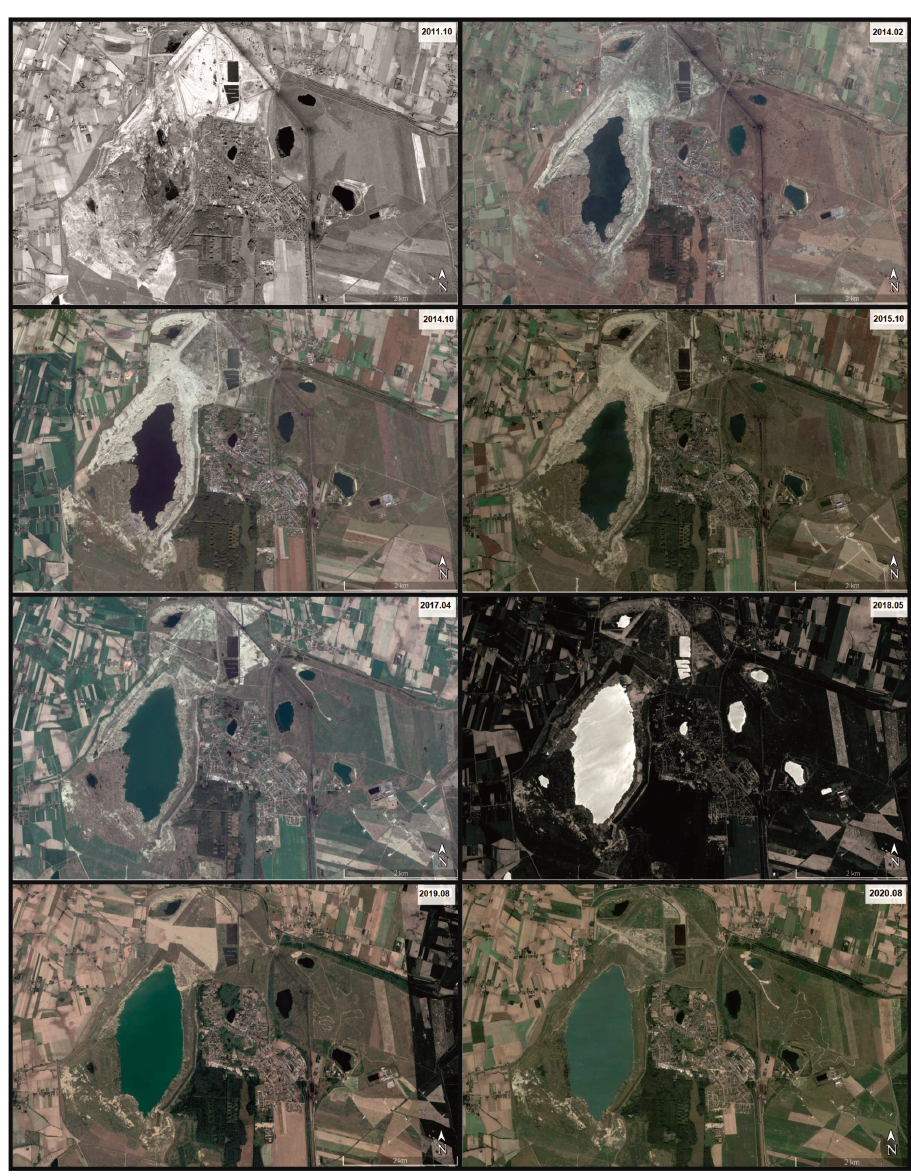
Figure 7. Illustration of changes in the surface area of the Kleczew reservoir emerging in the excavation after the Kazimierz Pó ł noc open pit mine in the years 2013–2020 (based on data obtained from GoogleEarthPro).